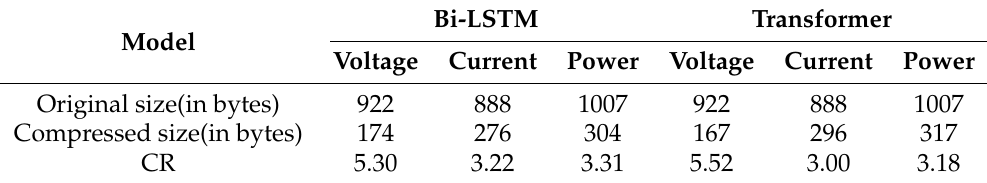
Table 2. Compare the CR results of using Bi-LSTM and